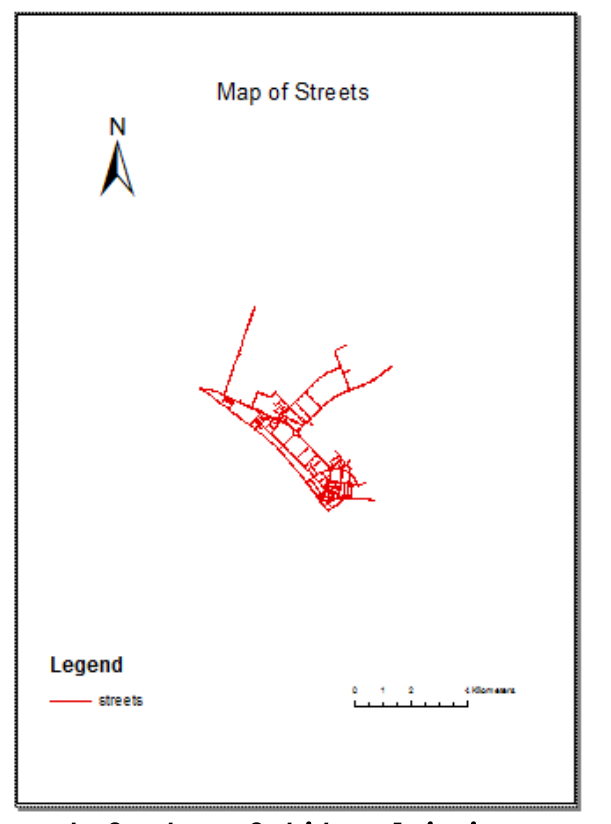
Fig.11: The network of roads map for high resolution image at 1:100,000 scale.